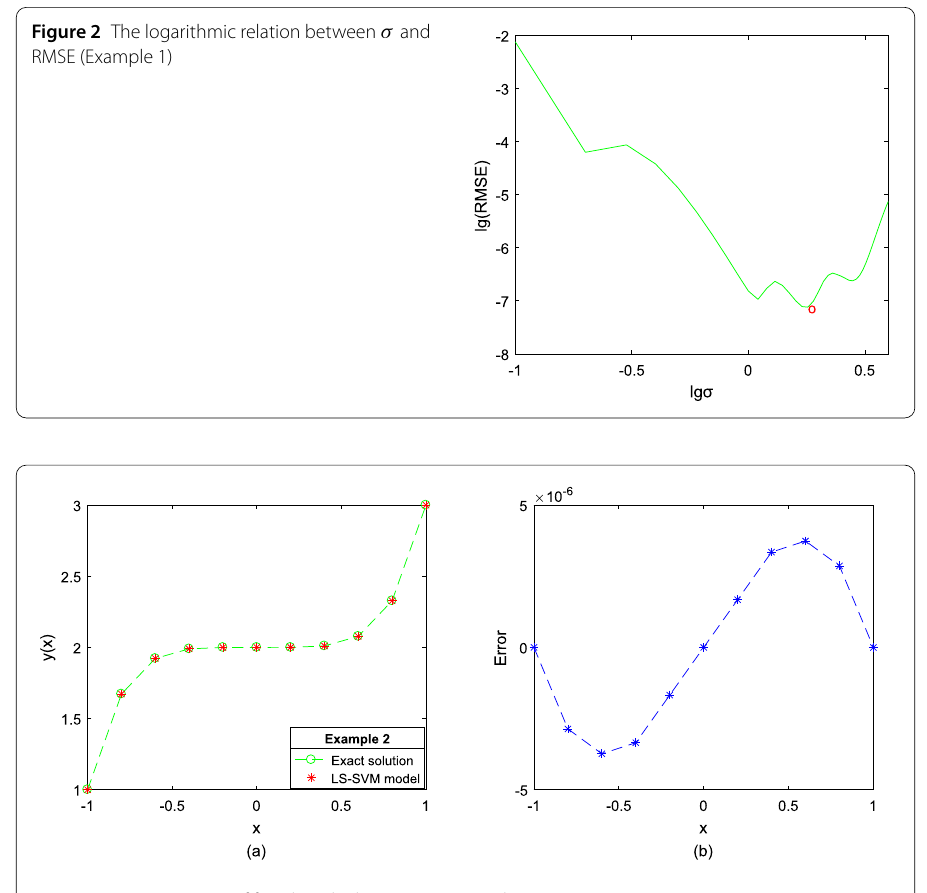
Figure 3 Two-point BVP of fourth-order linear ODE (Example